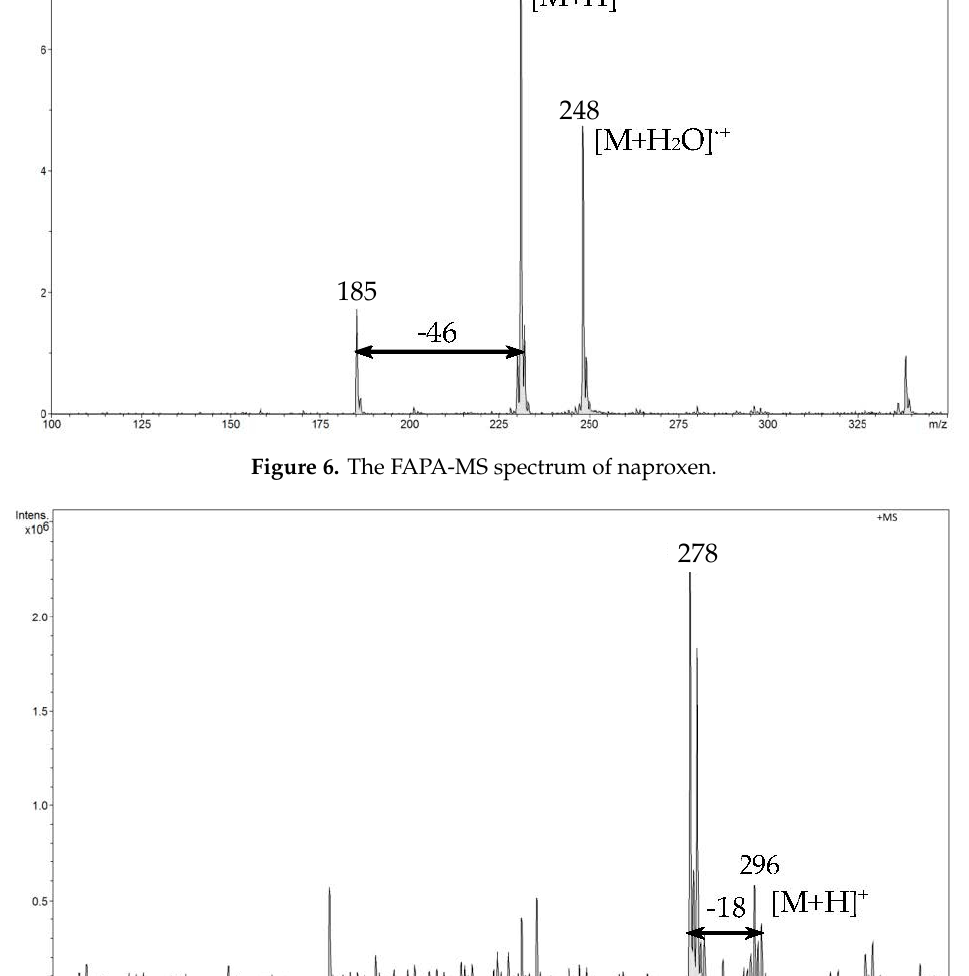
Figure 7. The FAPA-MS spectrum of Figure 7. The FAPA ‐ MS spectrum of diclofenac. Figure 7. The FAPA ‐ MS spectrum of diclofenac.